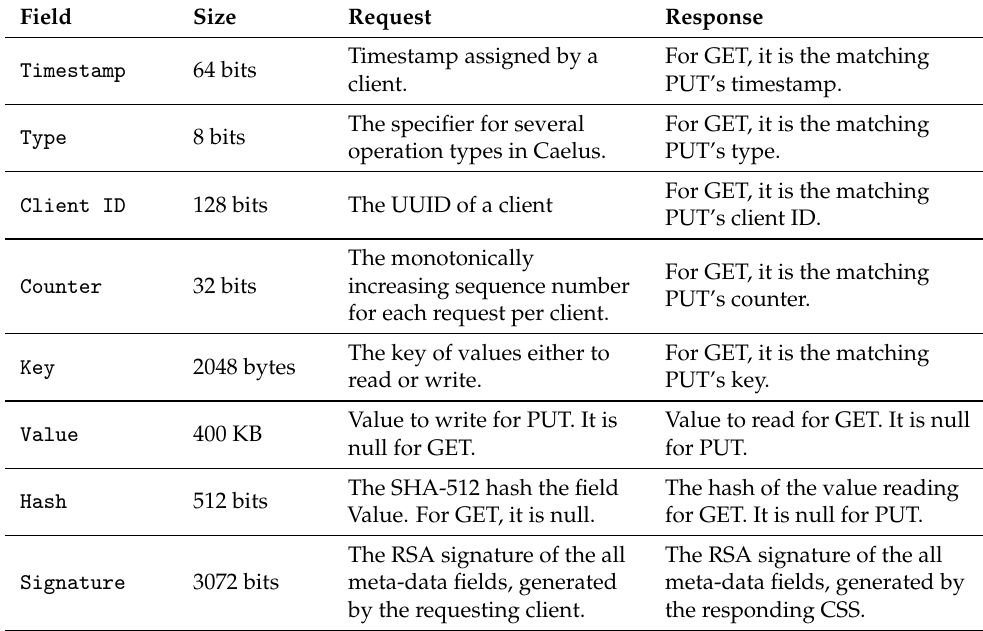
Table 1. CSS Request and Response Format